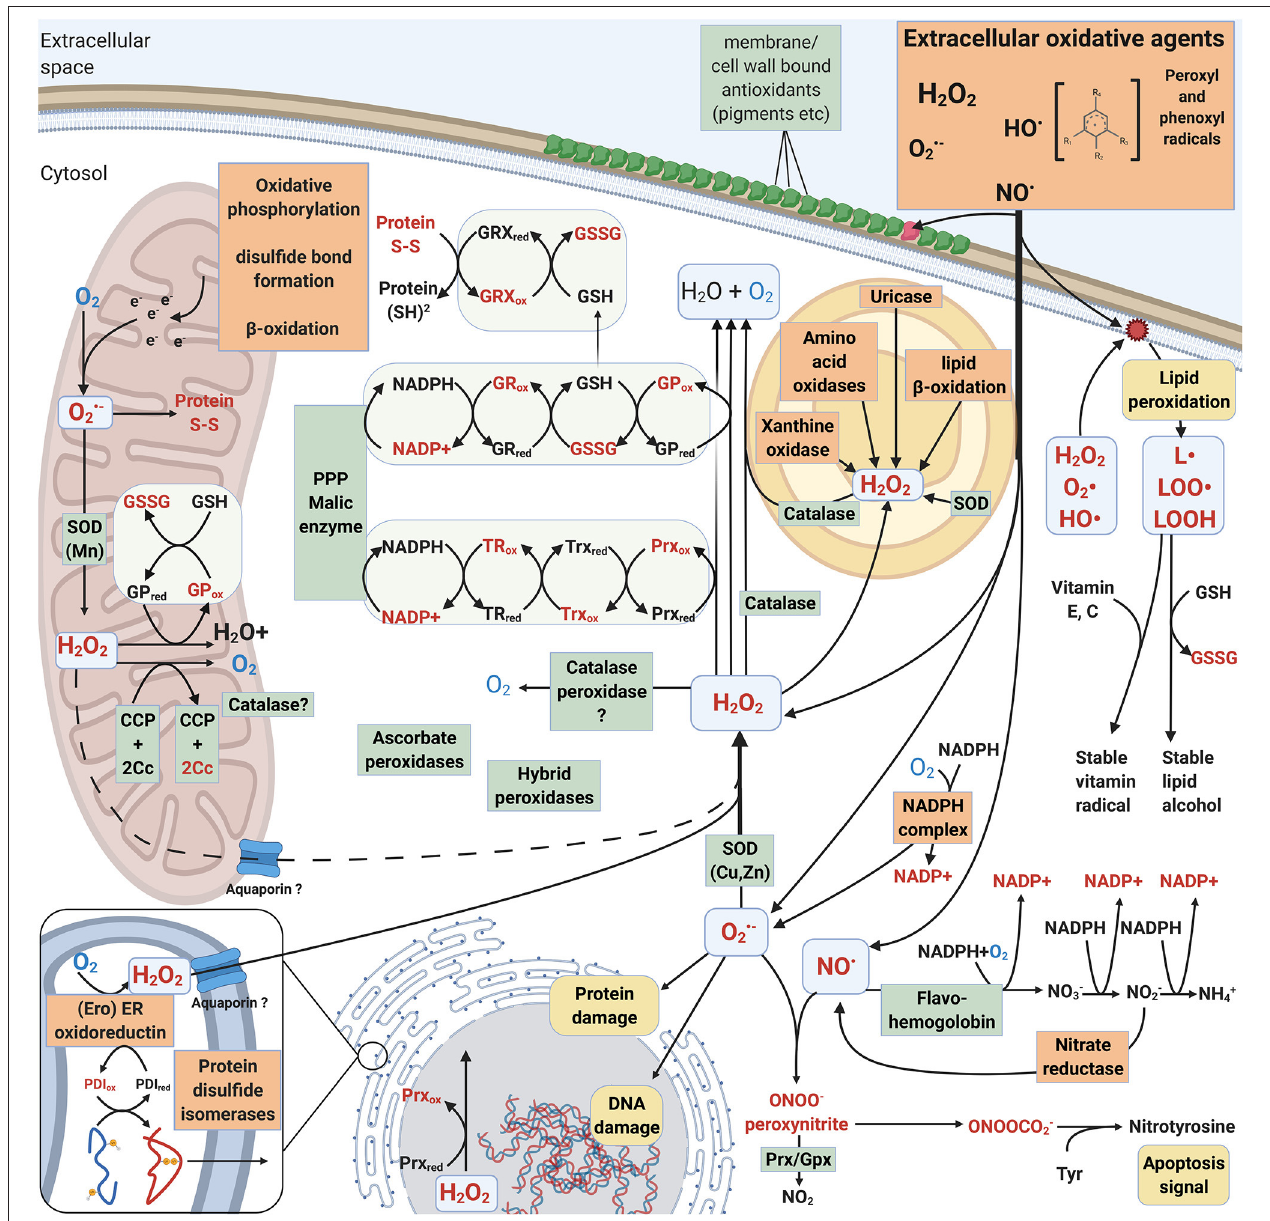
FIGURE 3 | Intracellular mechanisms involved in generation and mitigation of oxidative stress created by ROS and RNS. Oxidized compounds, radicals and proteins are indicated in red. L • = Lipid radical, LOO • = Lipid peroxyl radical, LOOH = lipid hydroperoxide. Mechanisms that increase oxidative stress are boxed and highlighted with orange. Mechanisms that decrease oxidative stress are pointed out in green